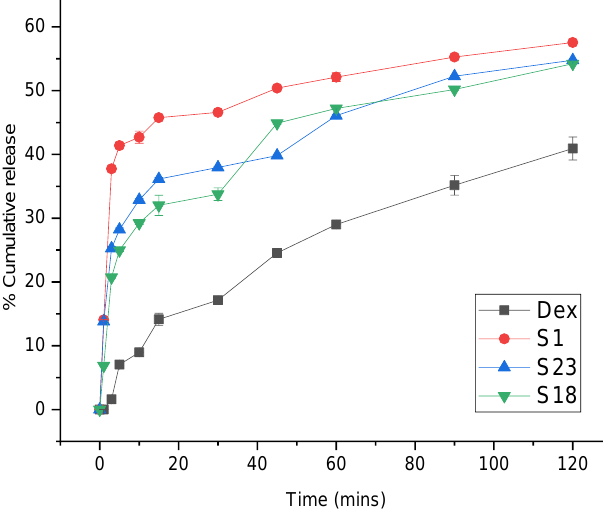
Figure 5. TGA and DSC graphs of Dex, S1, S18, and S23.